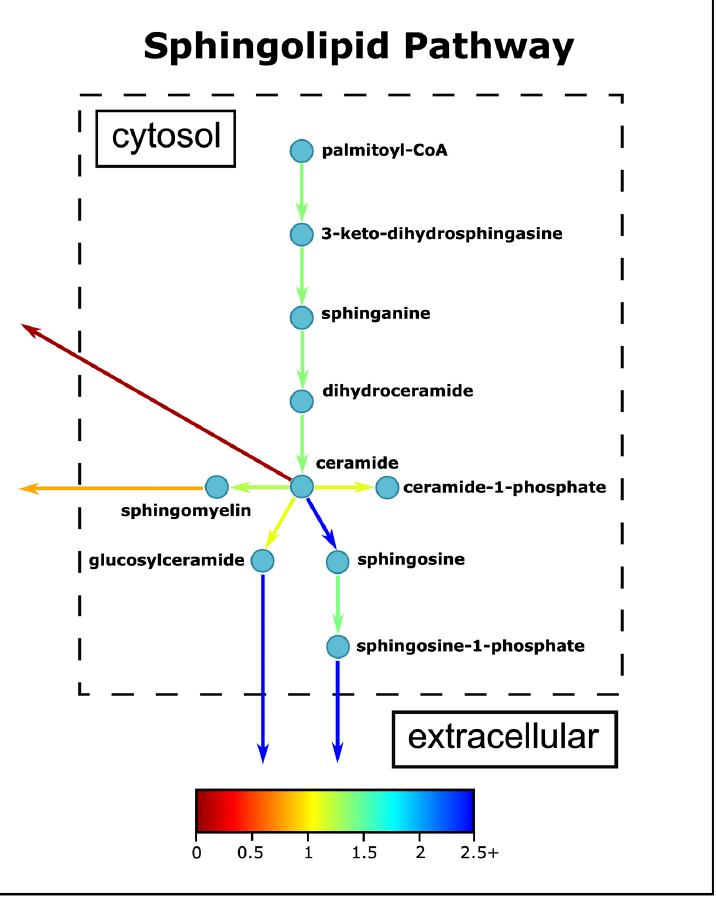
Figure 7. Simplified sphingolipid pathway. The colors indicate the ratio of average fluxes of ASD to control model.